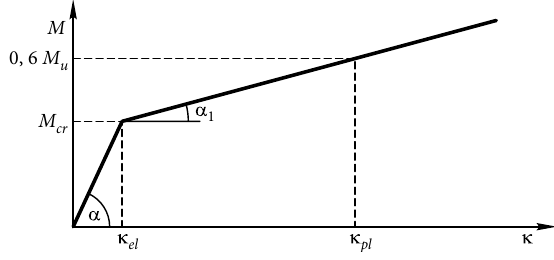
10 pav. Lenkiamojo gelžbetoninio elemento M ir κ diagrama Fig. 10. − κ M diagram of the RC element in bending